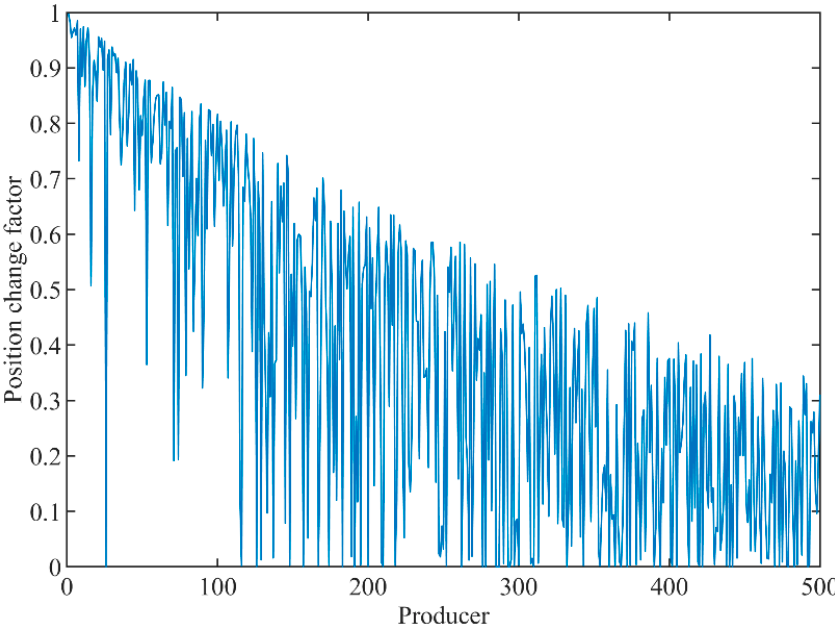
Figure 1. Relationship between location variation coefficient and numbering of producers.